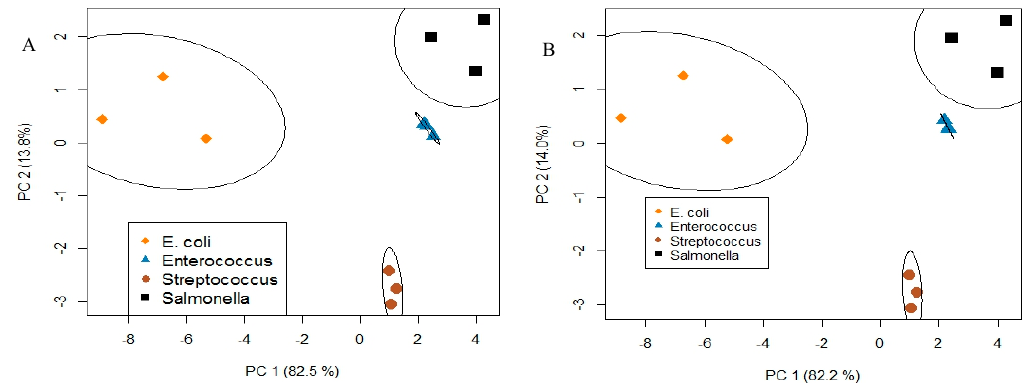
Figure 7. PCA analysis and plot results in clustering with respect to a bacteria type with good resolution using ( A ) six receptors (3 saccharides and 3 lectins) and ( B ) four receptors (3 saccharides and conA lectin). It is shown that a reduced array retains the ability to distinguish four